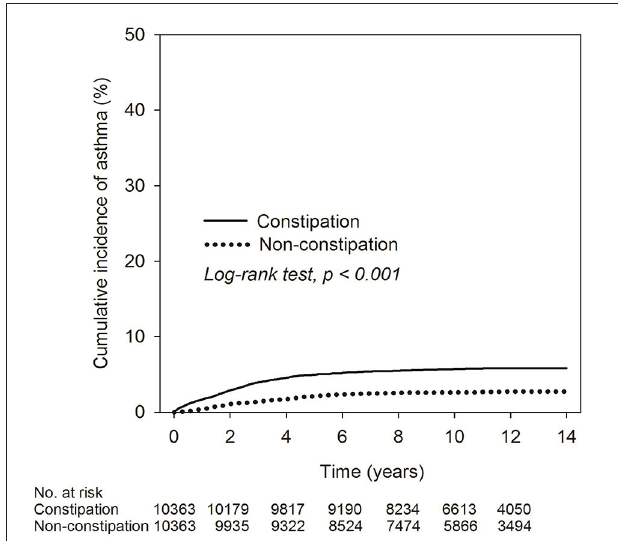
FIGURE 2 | Kaplan–Meier curve of cumulative incidence proportion of asthma in constipation and non-constipation